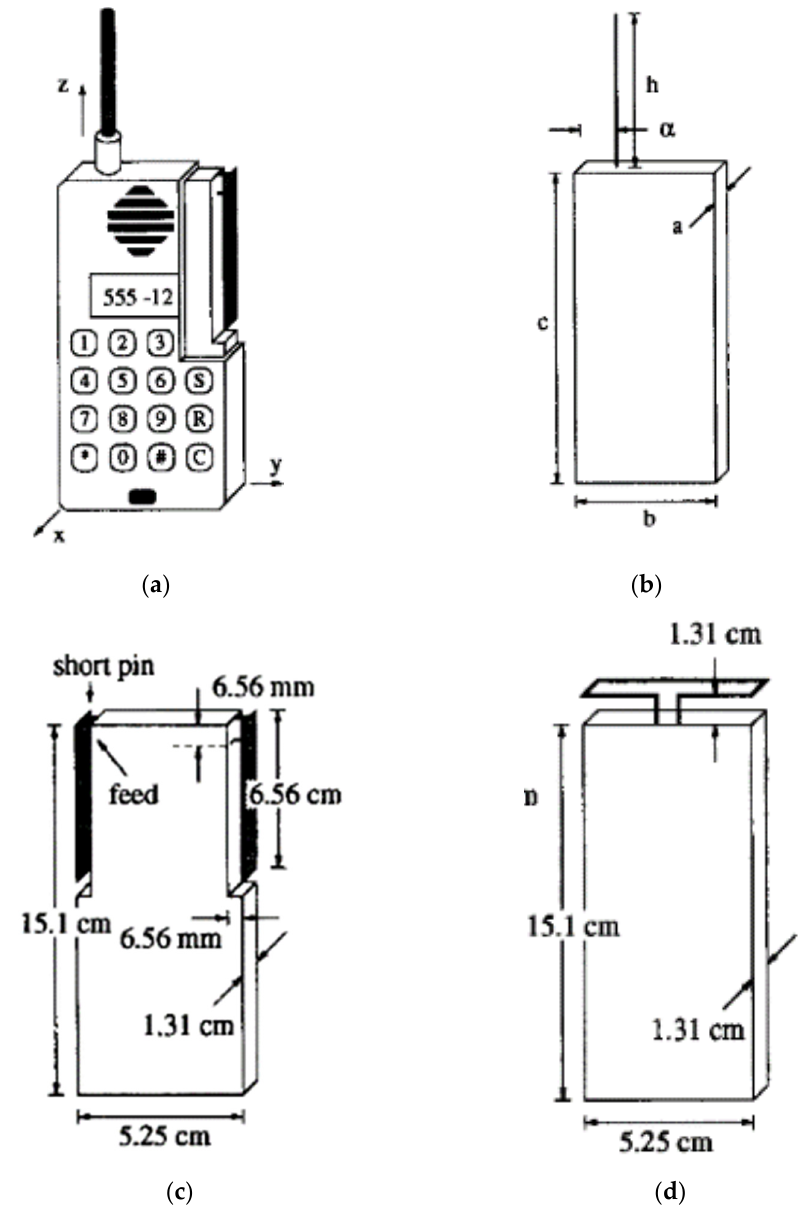
Figure 4. ( a ) Typical handset geometry showing the monopole and PIFA elements. Configuration and dimensions for the ( b ) monopole, ( c ) dual PIFA, and ( d ) top-mounted loop on the handset [55].